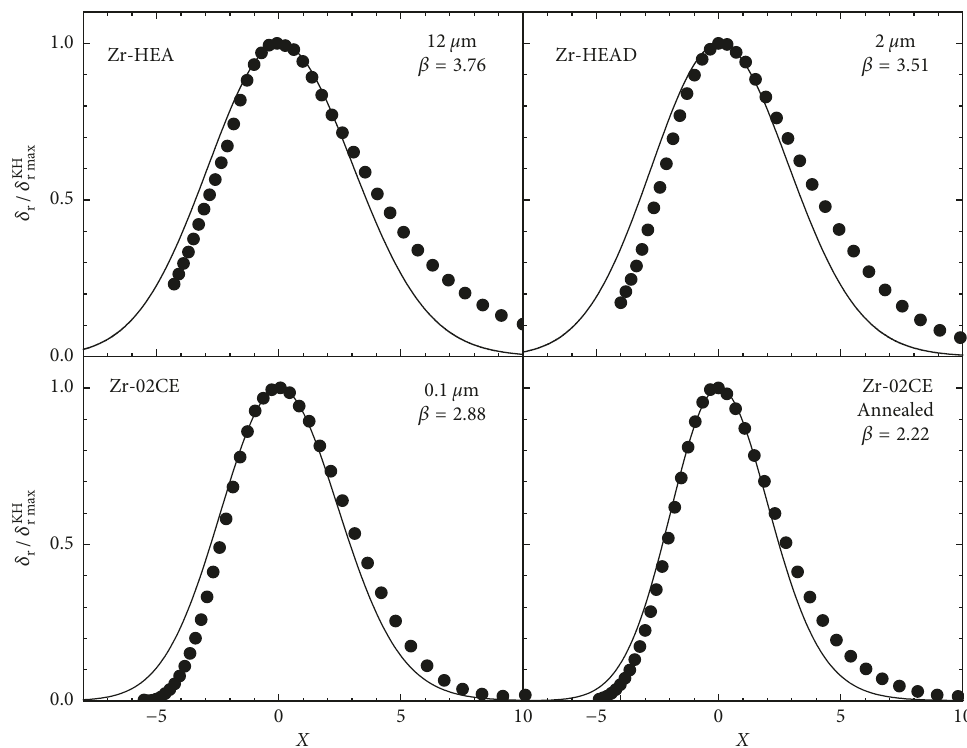
Figure 9: Experimental (points) and theoretical (solid lines) dependences of the normalized relaxation components of the decrement in the samples shown in Figure 3. The variable x U 0 and T P are taken from Table